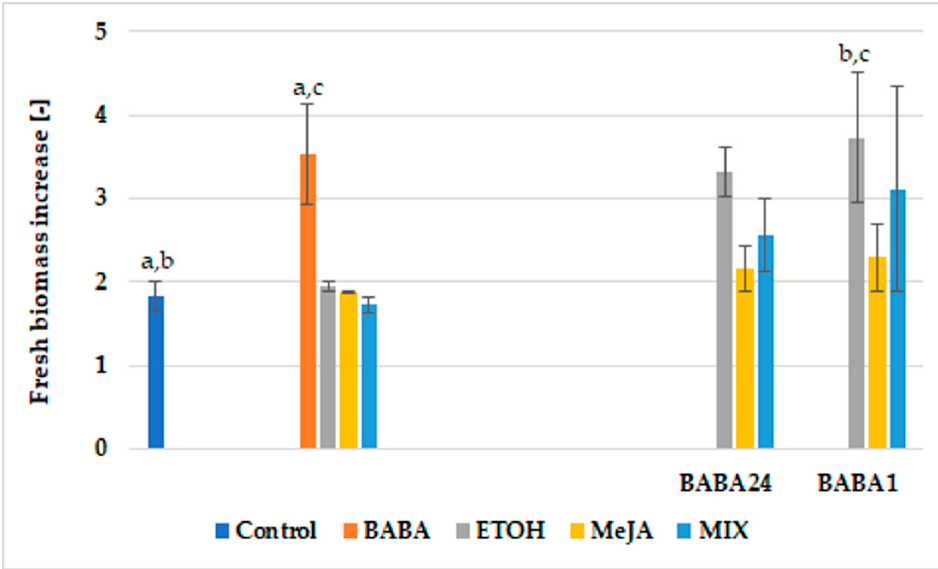
Figure 1. Fresh biomass increase of hairy roots cultivated under various culture conditions: control—untreated roots collected at day of inoculation (day “0”); BABA—roots treated with 100 µM β -aminobutyric acid (BABA) for 14 days; ETOH—roots treated with ETOH for 14 days without BABA, and variants: treated 24 h or 1 week with BABA with subsequent addition of ETOH for 14 days; MeJA—roots treated with MeJA for 14 days without BABA, other variants: treated 24 h or 1 week with BABA with prior to addition of MeJA for 14 days; MIX—roots cultivated for 14 days without BABA, and variants: treated 24 h or 1 week with BABA with subsequent addition of MIX of elicitors. Data represent mean values ± SD from three independent experiments. Data within groups denoted with the same letters are statistically significant ( p ˂ 0.05).